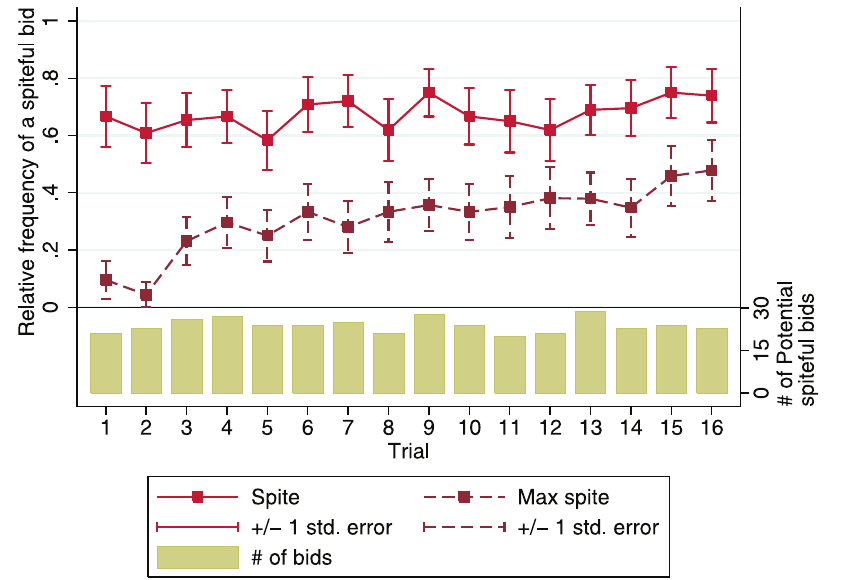
Figure 1. Time series of the relative frequencies of spiteful and maximally spiteful bids, conditional on bids being potentially spiteful. The solid line indicates the observed relative frequency of subjects making a spiteful bid in each trial, and the dashed line indicates the observed relative frequency of a maximally spiteful bid. Capped spikes display the standard errors of the mean in each trial. The subgraph displays the number of opportunities to observe a spiteful bid in each trial, and suggests that the relative frequency of observing spite is not related to the